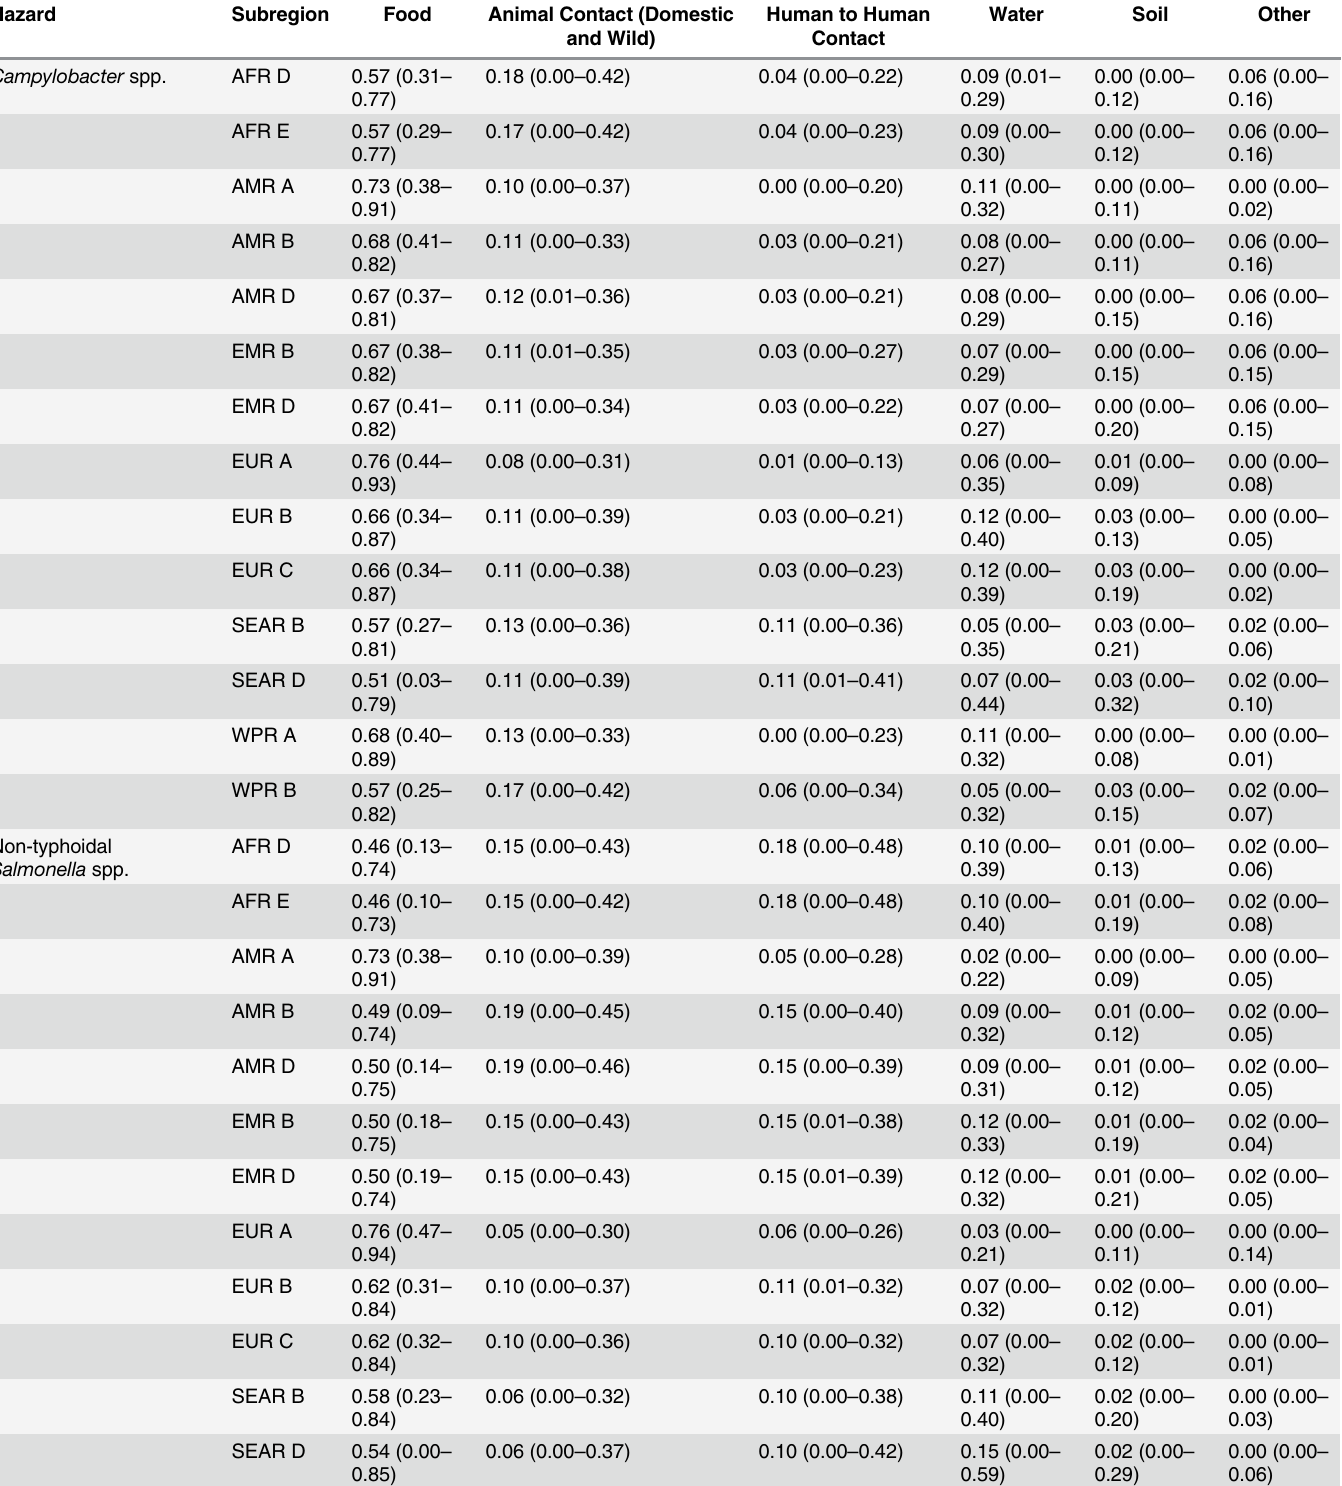
Human to Human Water Soil Other and Wild) Contact